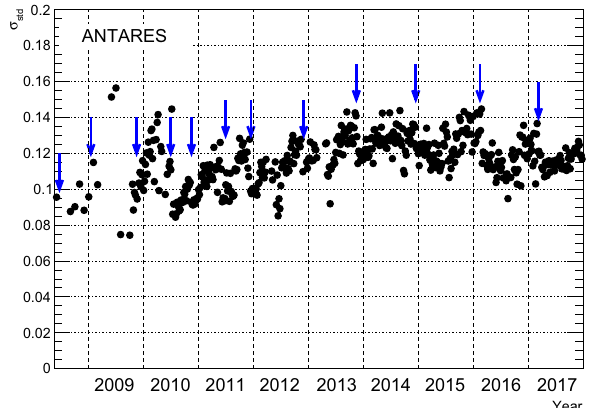
Fig. 5 Standard deviation σ std of the relative photon detection effi- ciency as a function of time. The blue arrows indicate the periods in which high voltage tuning of the PMTs has been performed